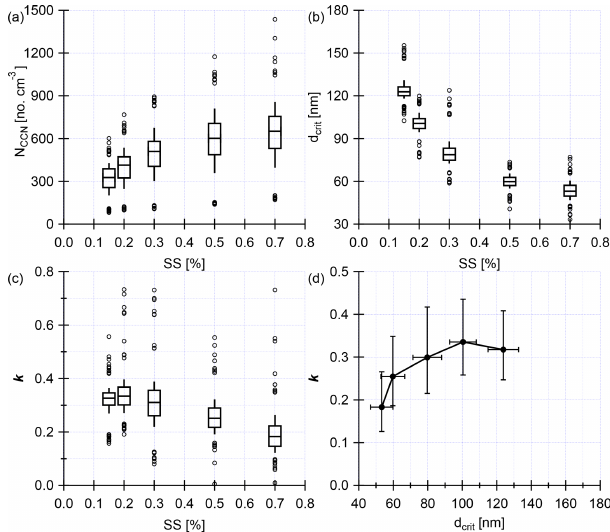
Figure 11. Boxplots of N CCN (a) , d crit (b) and κ (c) at different supersaturations (SS). Whiskers show the 10th to 90th percentiles. Circles show the outliers (1%). (d) κ as a function of d crit . Error bars of d crit and κ show 1 standard deviation and 1 geometric stan- dard deviation, respectively.